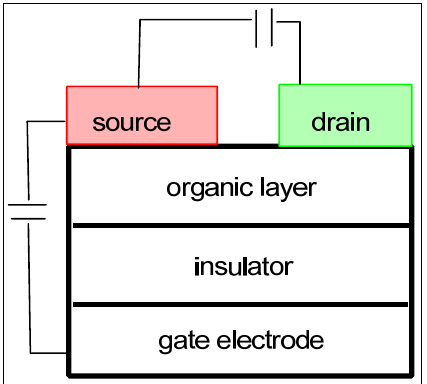
Figure 6. Schematic diagram of the device configuration of an OFET.